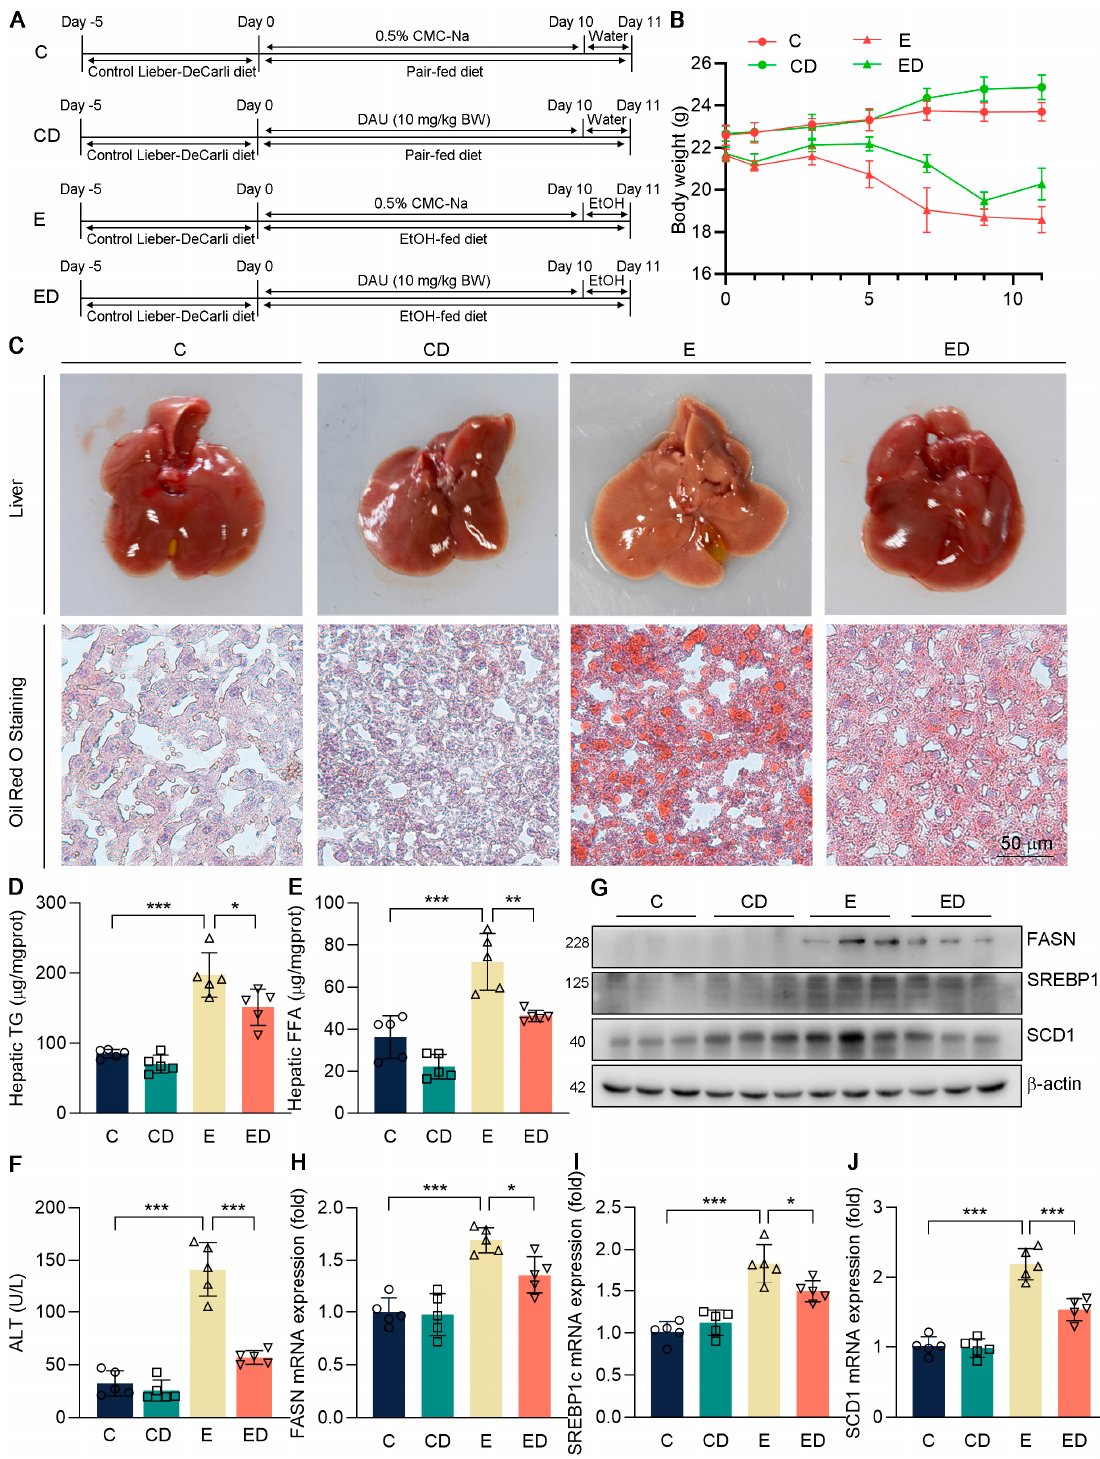
Figure 1. The effect of DAU on hepatic lipid accumulation and liver injury induced by alcohol. ( A ) Schematic diagram of animal experiments. ( B ) Weight change of mice. ( C ) Liver and hepatic Oil Red O staining of mice. Hepatic ( D ) TG and ( E ) FFA levels. ( F ) Serum ALT level. ( G – J ) Protein and mRNA expression of FASN, SREBP1c, and SCD1 in mice liver. Data are mean ± SD using one − way ANOVA ( n ≥ 3), * p < 0.05, ** p < 0.01, *** p <